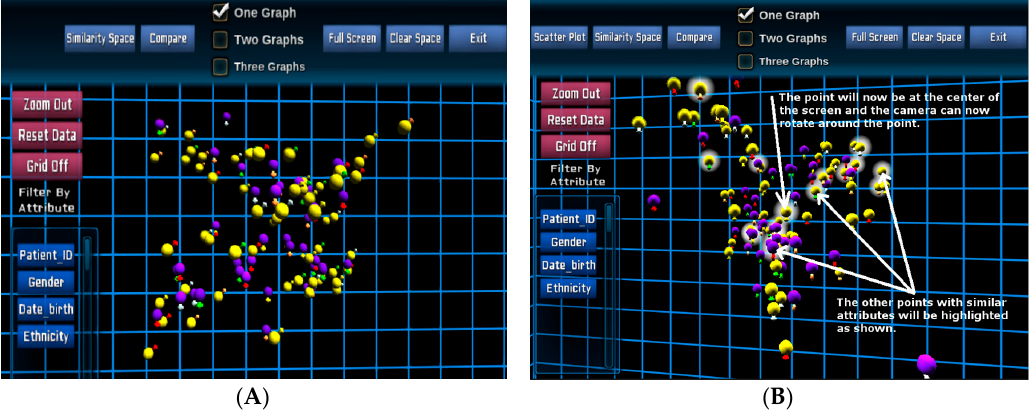
Figure 3. An overview of the patient population in the similarity space in a Unity3D environment, ( A ) at the navigational stage and ( B ) when highlighting the patients. This visualisation provides a smooth, ergonomic and gaming-friendly environment to analysts.